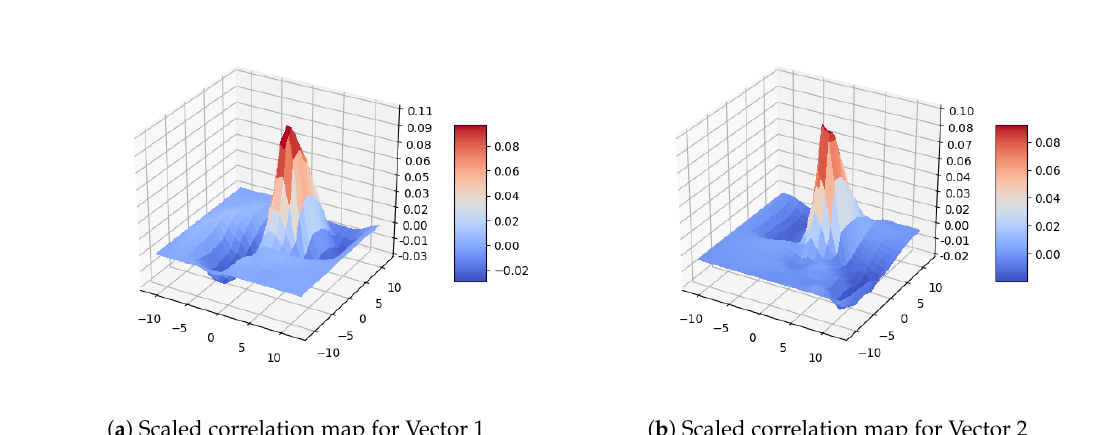
Figure 8. Scaled 3D map for the correlation matrices of Figure 7a,b